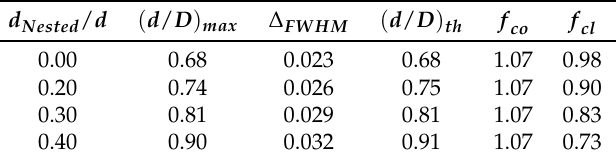
Table 1. Summary of main results and